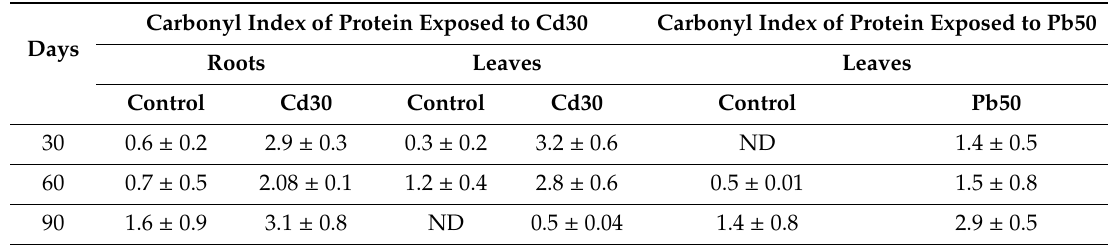
Table 2. Protein carbonyl indexes of Paspalum fasciculatum Willd (Ex Flugue) (Poaceae) organs.